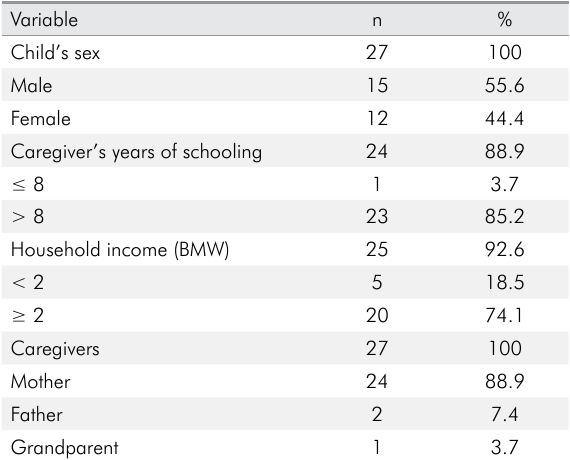
Table 1. Sociodemographic and clinical data of the sample (n = 27).